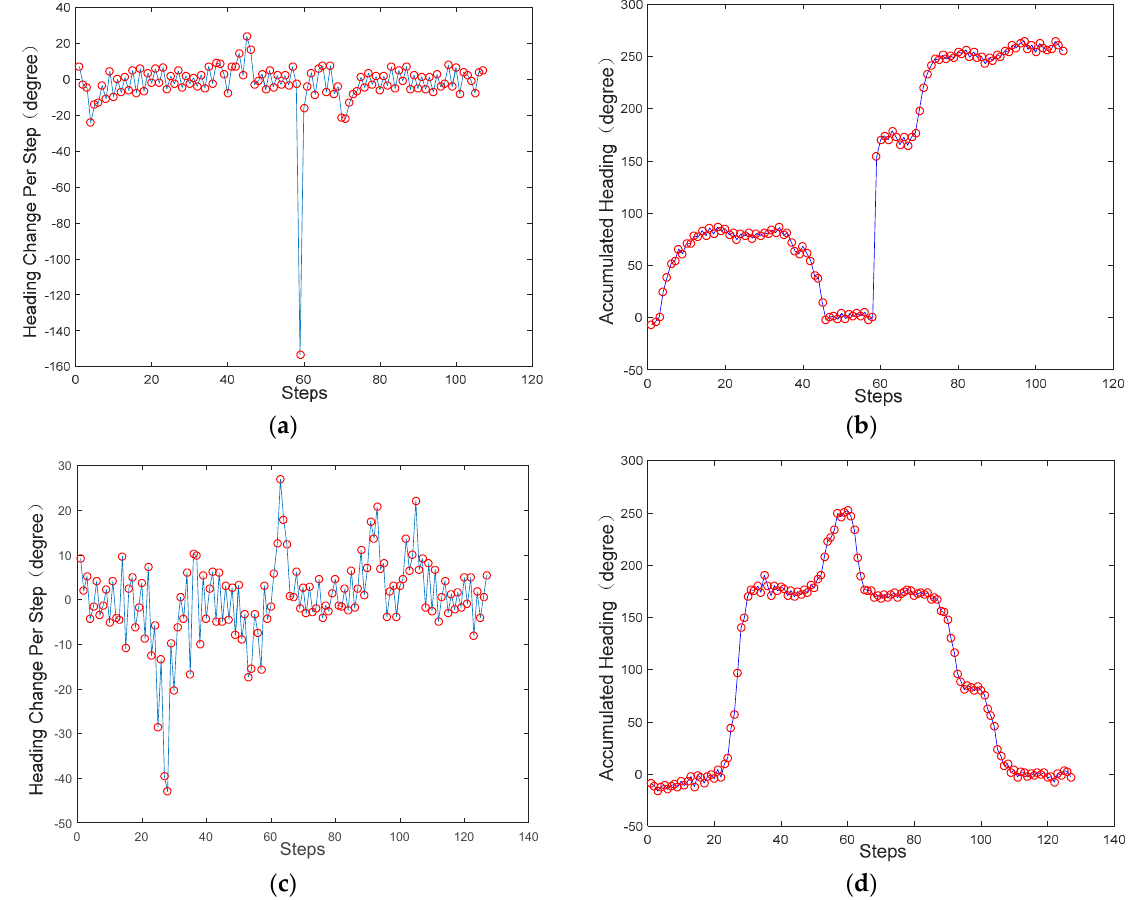
Figure 9. Orientation estimation result of PDR: ( a ) the orientation changes relative to the last step; ( b ) the overall heading estimation relative to the starting time; ( a ) and ( b ) are the result for scenario 1; ( c ) and ( d ) are the corresponding results of scenario 2.